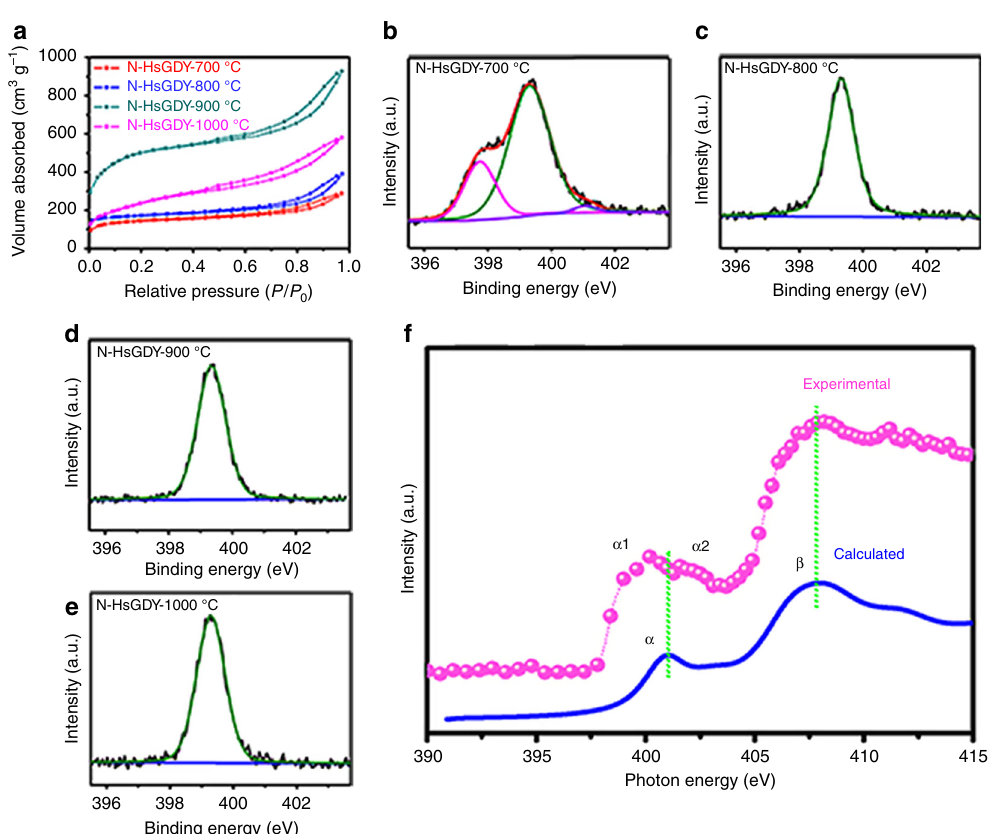
Fig. 2 Structural information for pyridinic nitrogen-doped hydrogen-substituted graphdiyne. a Nitrogen adsorption/desorption isotherms for all of the pyridinic nitrogen-doped hydrogen-substituted graphdiyne (N-HsGDY) catalysts. b – e High-resolution X-ray photoelectron spectroscopy (XPS) spectra of N 1 s for N-HsGDY treated at 700 °C (N-HsGDY-700 °C) ( b ), N-HsGDY treated at 800 °C (N-HsGDY-800 °C) ( c ), N-HsGDY treated at 900 °C (N- HsGDY-900 °C) ( d ), and N-HsGDY treated at 1000 °C (N-HsGDY-1000 °C) ( e ). f The experimental and calculated curves of N K-edge X-ray absorption near-edge structure (XANES) spectra for N-HsGDY-900